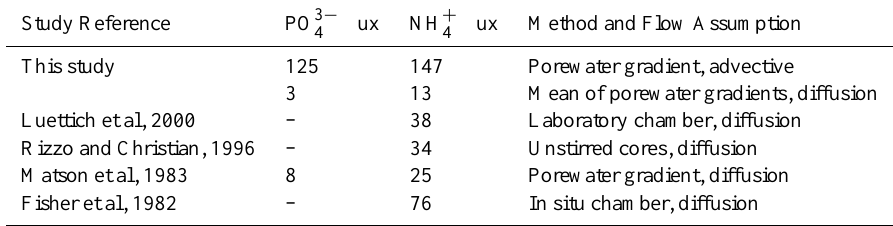
Table 2. A comparison of the average diffusive and advective fluxes (mgN or Pm − 2 d − 1 ) from this and previous